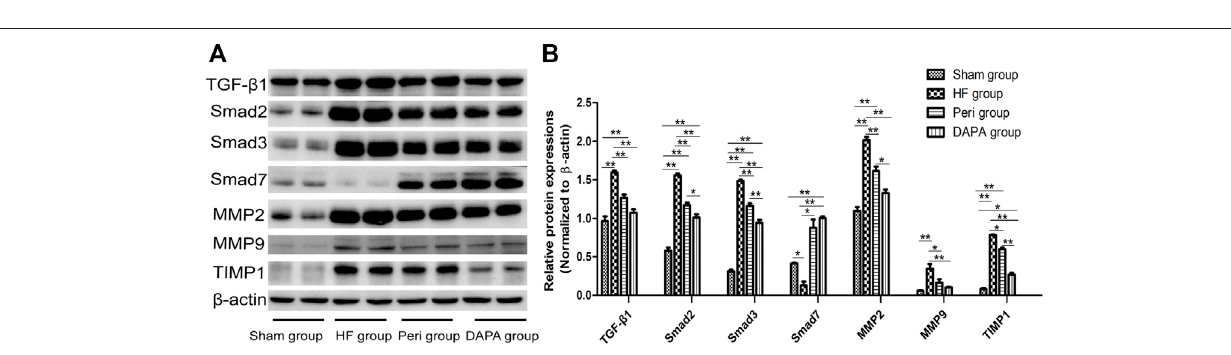
Frontiers in Pharmacology |